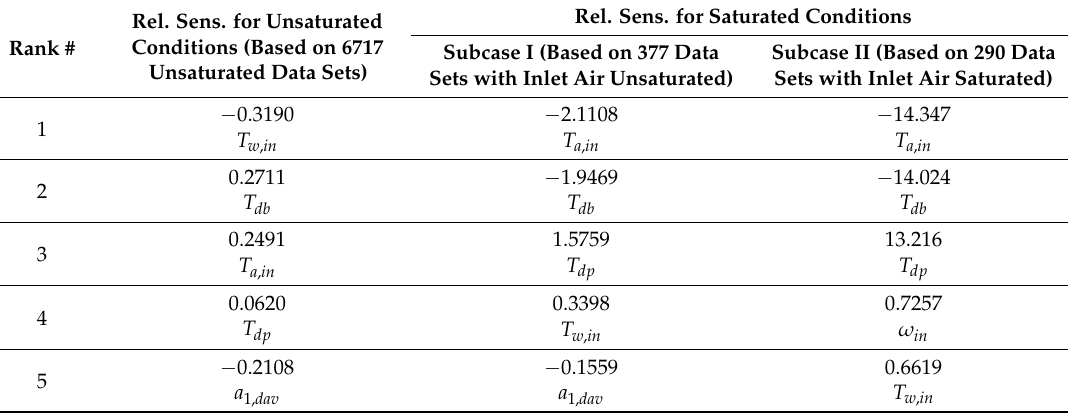
Table 10. Cross-comparison of the top five relative sensitivities for the response of air outlet rel. humidity, RH ( 1 )